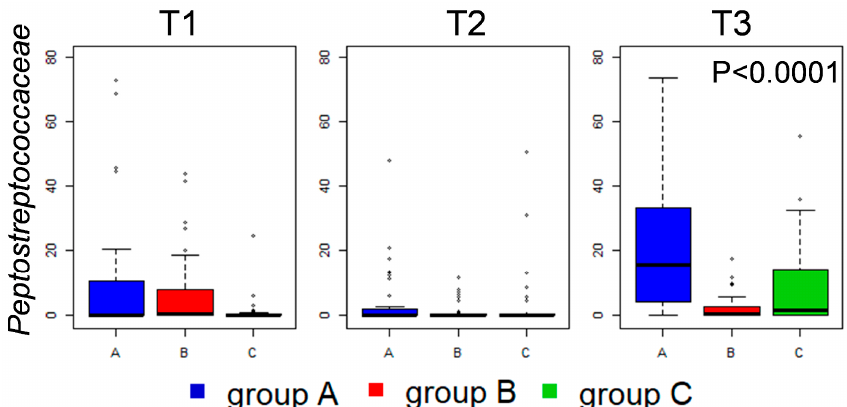
Figure 4. Relative abundance distributions of Peptostreptococcaceae family in the ileum microbiota of broilers. Box and whiskers distributions of relative abundances (%) in all samples, at the three time points (from left to right) are depicted (blue, group A; red, group B; green, group C). Benjamini–Hocherg corrected p values obtained from Kruskal–Wallis test are reported when statistical significance was reached ( p < 0.05).